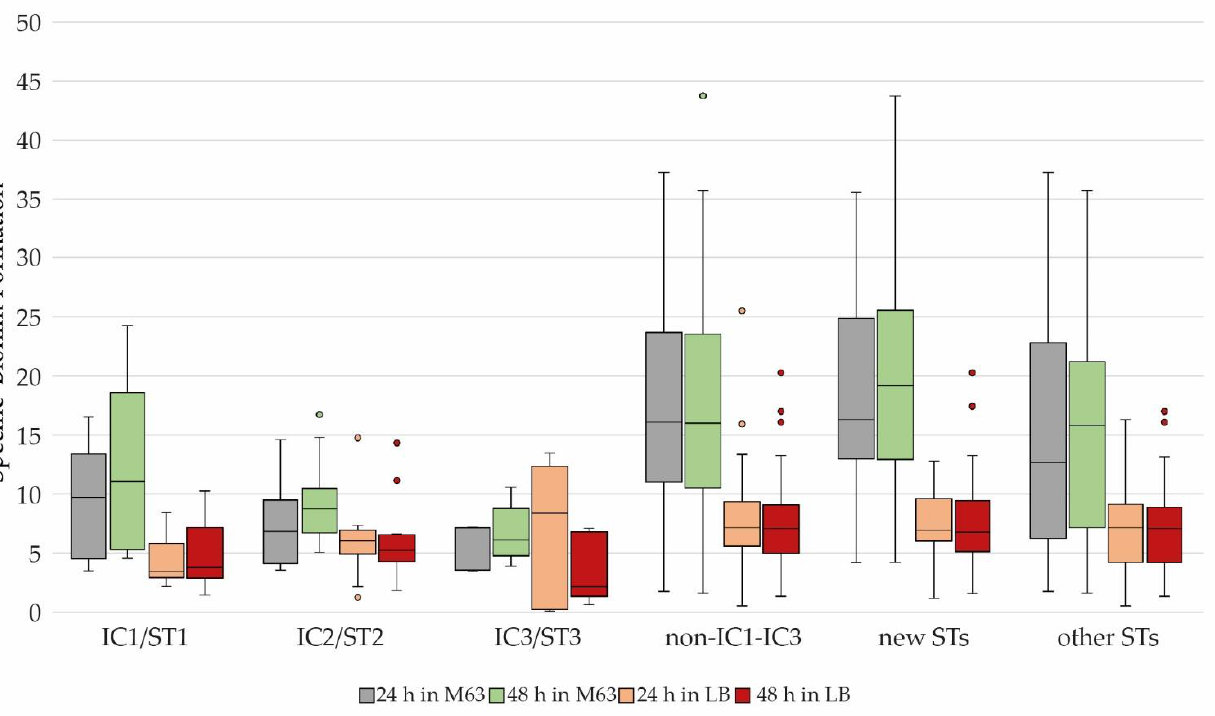
Figure 4. Distribution of the SBF of 78 equine A. baumannii isolates based on their STs/ICs depending on incubation time and medium used. Number of isolates: IC1/ST1 = 8, IC2/ST2 = 16, IC3/ST3 = 5, non-IC1-IC3 = 49, other STs = 29, new STs = 21; other STs = non-ST1, -ST2, -ST3; new STs = ST1723-ST1744. All ICs/STs: p < 0.05, except for IC3/ST3: p = 0.613.